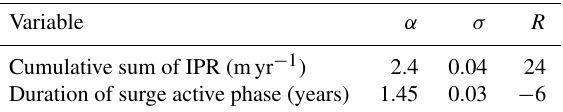
Table 3. Table of power law parameters: α represents the power law exponent. σ is the standard deviation associated with α . R rep- resents the log-likelihood ratio between power law and exponential